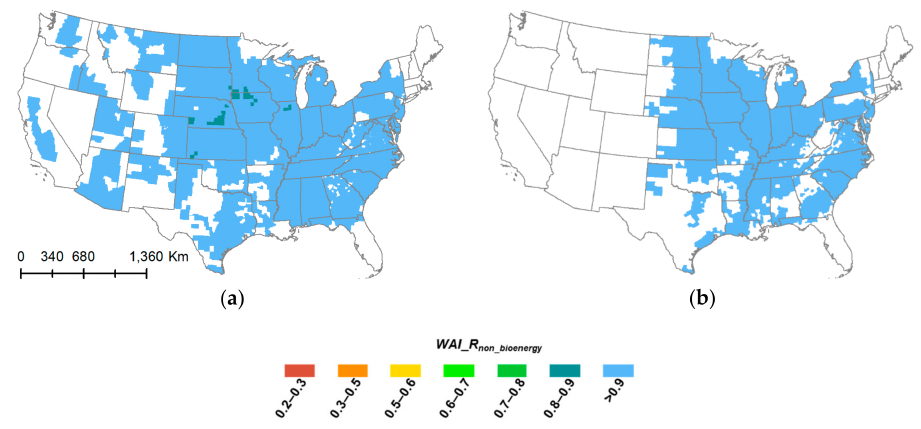
Figure 11. County-level crop-specific WAI_R non_bioenergy values based on acres of ( a ) corn grain and ( b ) soybeans harvested as biofuel feedstock only (i.e., acres harvested for food and feed purposes are excluded). For corn and soybeans, respectively, 30% and 12% of the total harvests in 2008 were biofuel feedstock. WAI_R non_bioenergy represents the fraction of green water resources available for other uses (e.g., food and feed), after meeting the crop water demand of bioenergy feedstock harvested from corn grain and